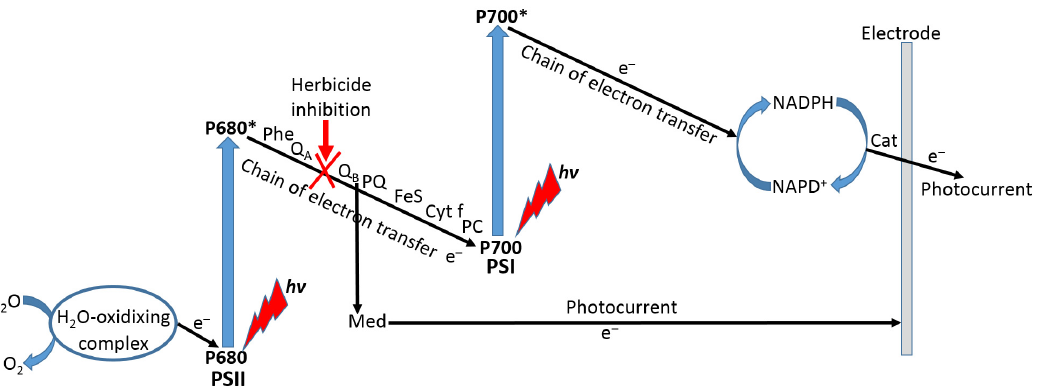
Figure 24. Schematic of photosynthetic electron transport chain (PET) consisting of photosystem II (PSII) oxidizing H 2 O and producing O 2 , and photosystem I (PSI) reducing NADP + to NADPH. P680 and P700 are special pairs composed of chlorophyll molecules being excited with light (P680* and P700* correspond to their excited states). Electron ‐ transfer chain components are abbreviated. The inhibition center and mediated effect can be localized approximately in the middle of the electron ‐ transfer chain between PSII and PSI.